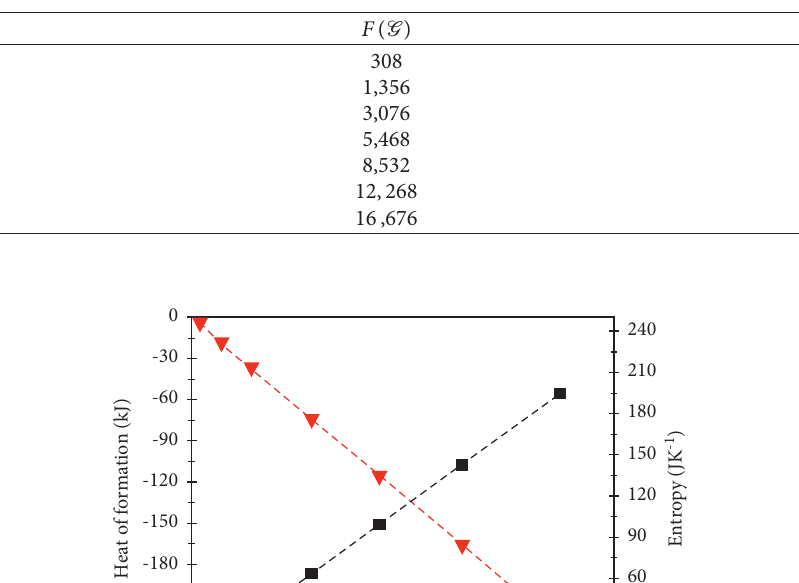
Table 5: Comparison of F ( G ) and AZI ( G ) indices for InP [ s , t ].